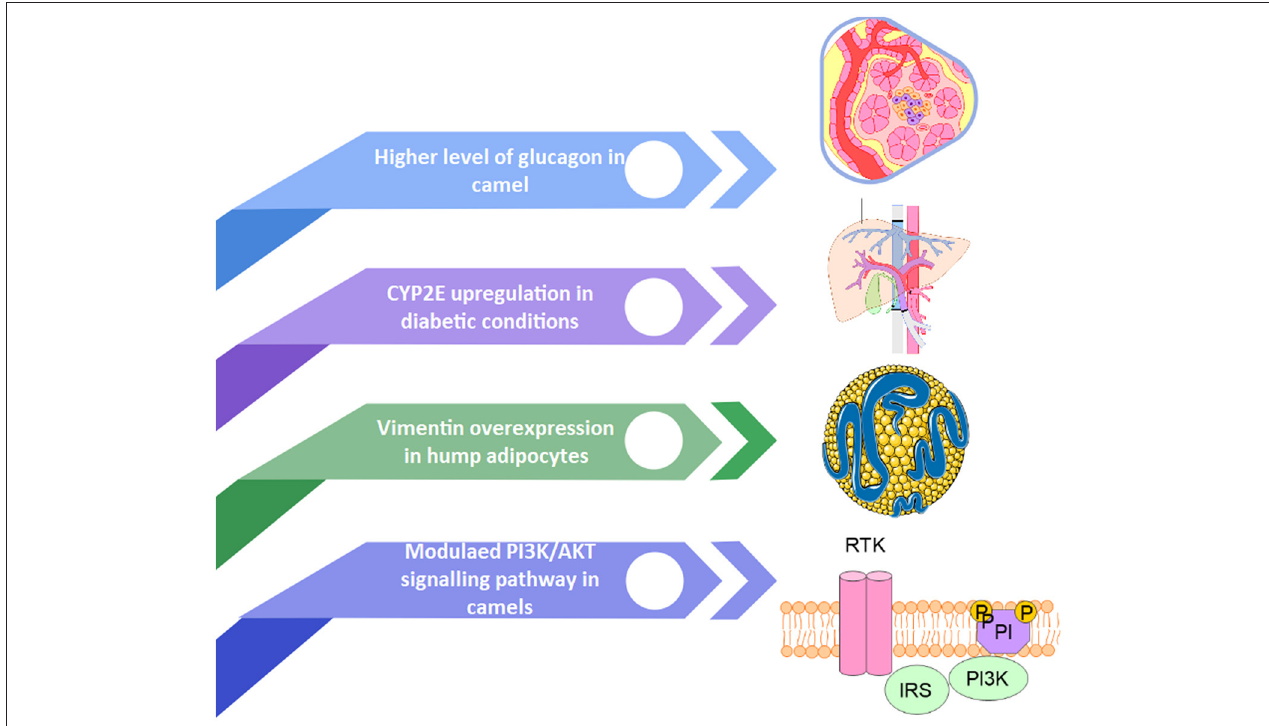
FIGURE 4 | The potential mechanisms of insulin resistance in